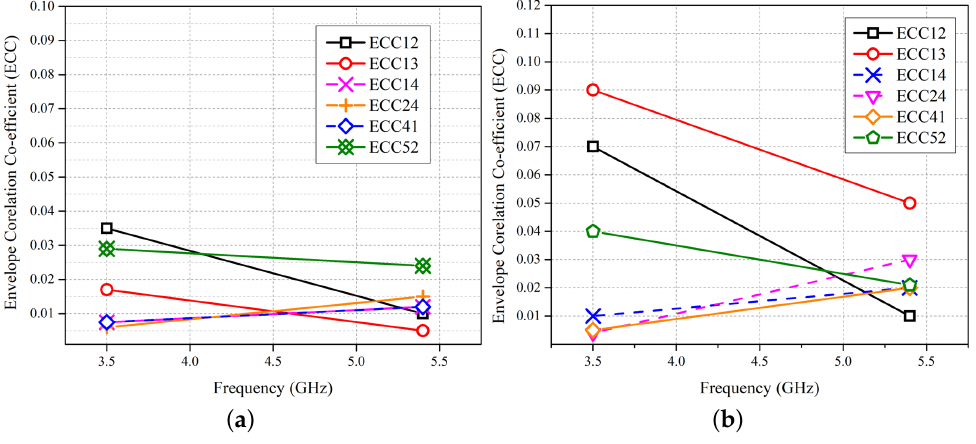
Figure 11. ( a ) Simulated and ( b ) measured ECC of the proposed MIMO antenna.